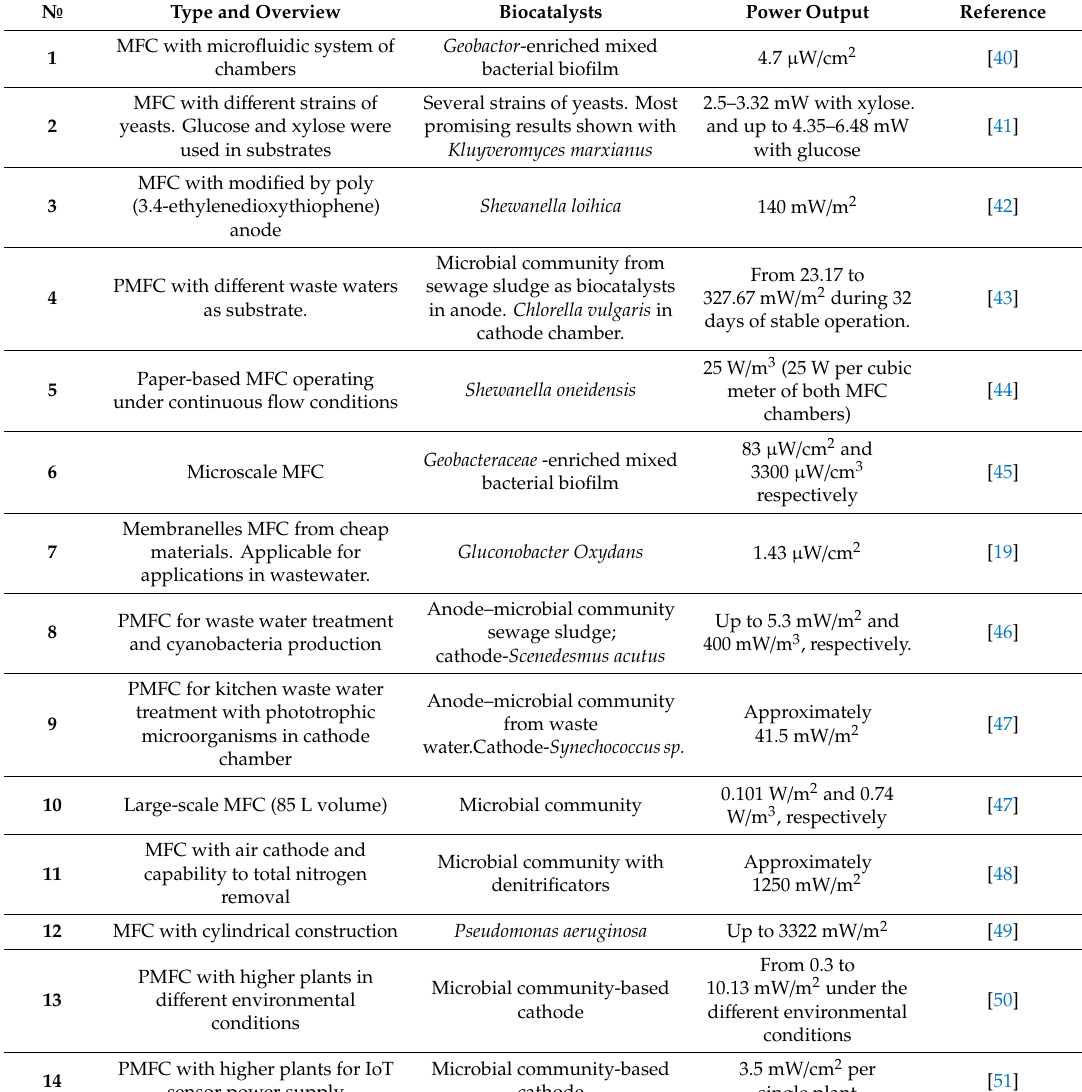
Table 1. Characteristics of several microbial fuel cells (MFCs) and phototrophic microbial fuel cells (PMFCs). Power output data given in the same scale as in the siting